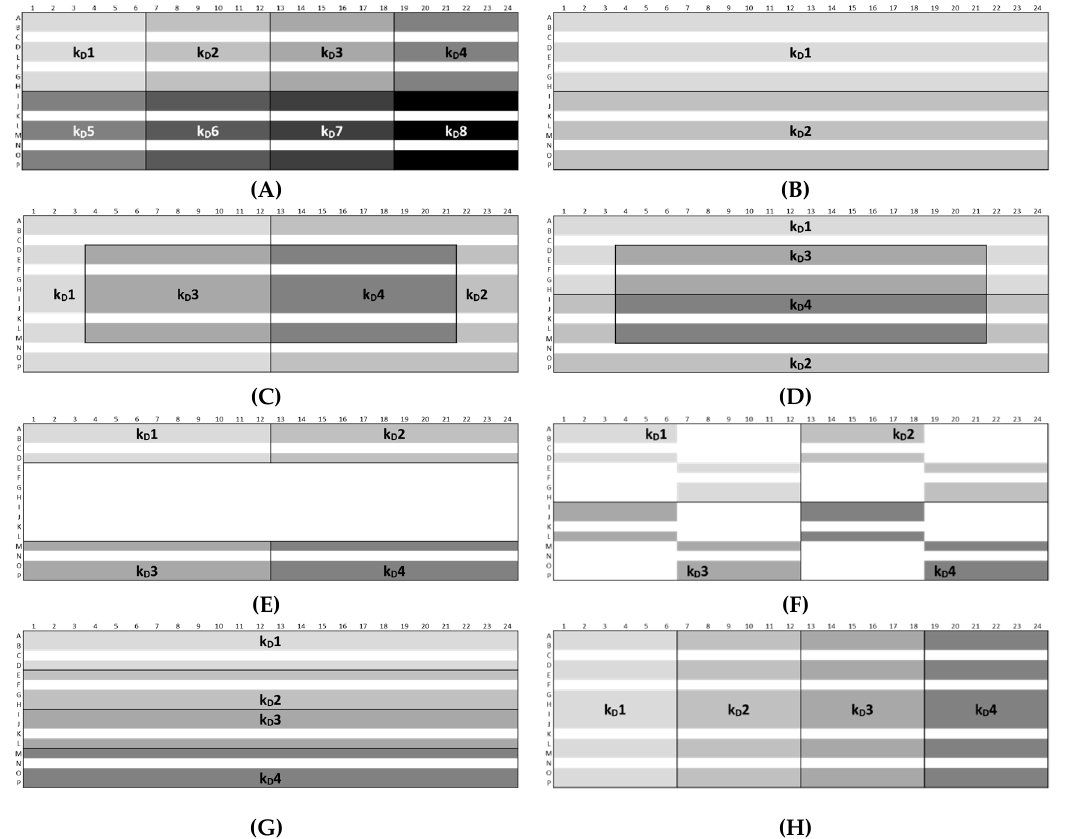
Figure 8. Plate designs ( A – H ) of the approaches Ac and Ph. “ k D # ” shows the wells used for the calculation of the single k D values. The white area shows omitted wells.